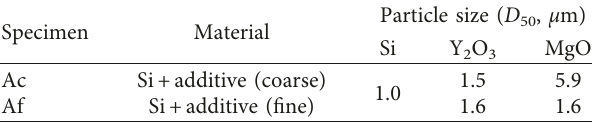
Table 1: The particle size and composition of the specimens.